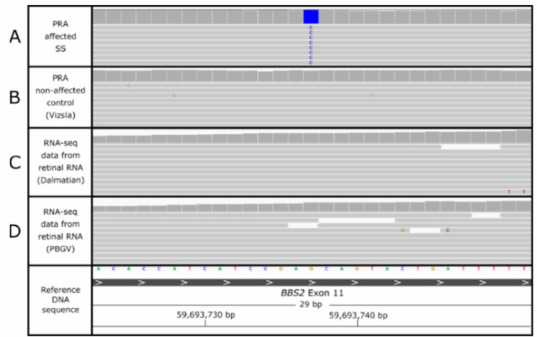
Figure 2. IGV display of WGS reads aligned across the BBS2 c.1222G>C SNV region. Grey horizontal bars show paired-end sequencing reads aligned to the canine reference genome across the BBS2 exon 11 location. Above these sequencing reads is a histogram representing sequencing coverage across the region. Track ( A ) shows the WGS reads from the PRA-affected SS (proband SS1). The blue block shows a homozygous SNV change from the reference nucleotide ‘G’ to a ‘C’ at position chr2:59693737. Track ( B ) shows WGS data from a PRA non-affected control genome (Hungarian Vizsla dog) that is homozygous for the reference ‘G’ allele. BBS2 is expressed in retinal tissue as demonstrated by RNA-seq alignment from two control dogs: one Dalmatian dog (track ( C )) and one Petit Basset Griffon Vend é en (PBGV) dog (track ( D )), both of which are also homozygous for the reference allele at this position.